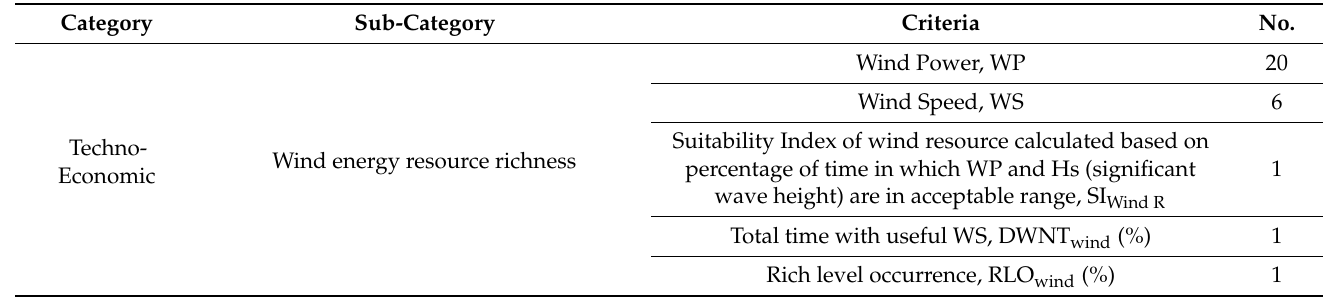
Table 2. Criteria used for evaluation, their relevant category, and frequency of mentions in the